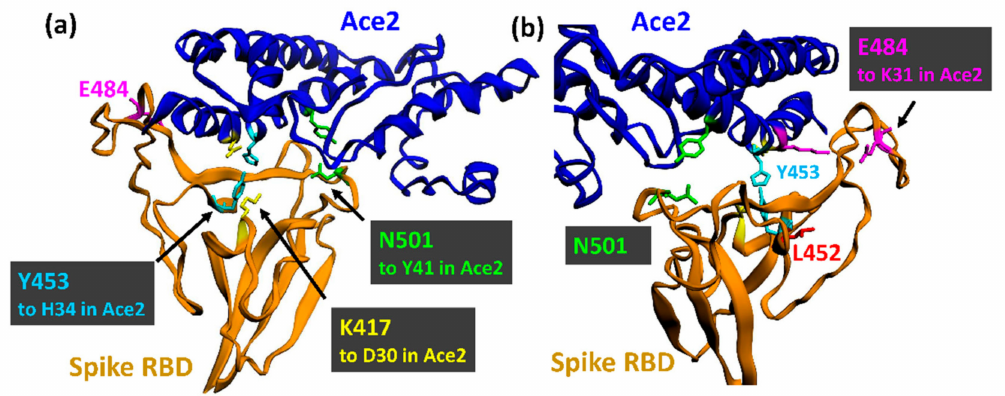
Figure 4. The receptor binding motif of spike (RBD). ( a ) View into the binding site. The key amino acids which are mutated in the variants (Table 1) are highlighted. The binding partners in hAce2 are shown in the same colour. Please note that L452 (red) is next to Y453 (light blue) but facing away from the binding site. E484 (magenta) is positioned at the rim of the binding site. ( b ) The backside of the binding site. The polar link between E484 with K31 in hAce2 and L452 are now visible. The other 14 residues making contact with hAce2 (G446, Y449, L455, F456, A475, F486, N487, Y489, Q493, G496, Q498, T500, G502, Y505) are not shown. hAce2 (blue): amino acids 19–99 and 312–395 are shown. Spike (orange): amino acids 393–516 are shown. The image was rendered with Ezmol 2.1 [63] using the structure PDB 7DF4.